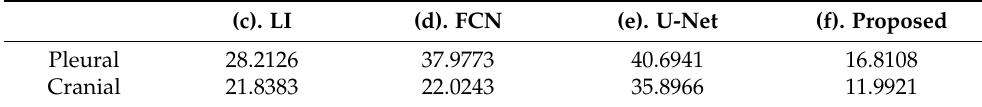
Table 1. MAE results of complement sinogram of simulation experiments.